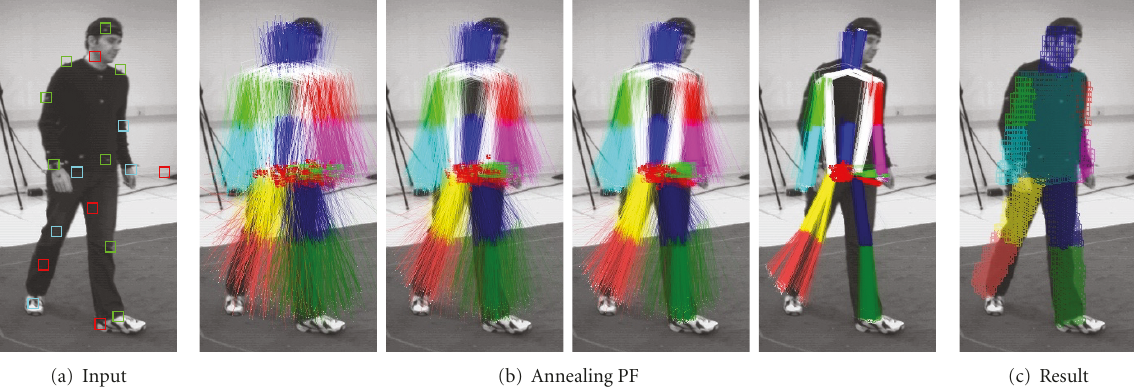
Figure 1: Annealed PF operation example. (a) The output of the employed marker detector where color boxes stand for correct (green), false (red), and missed (blue) detections. (b) The progressive fitting of particles driven by the annealing process and, (c) The final pose estimation (cid:8) Y t